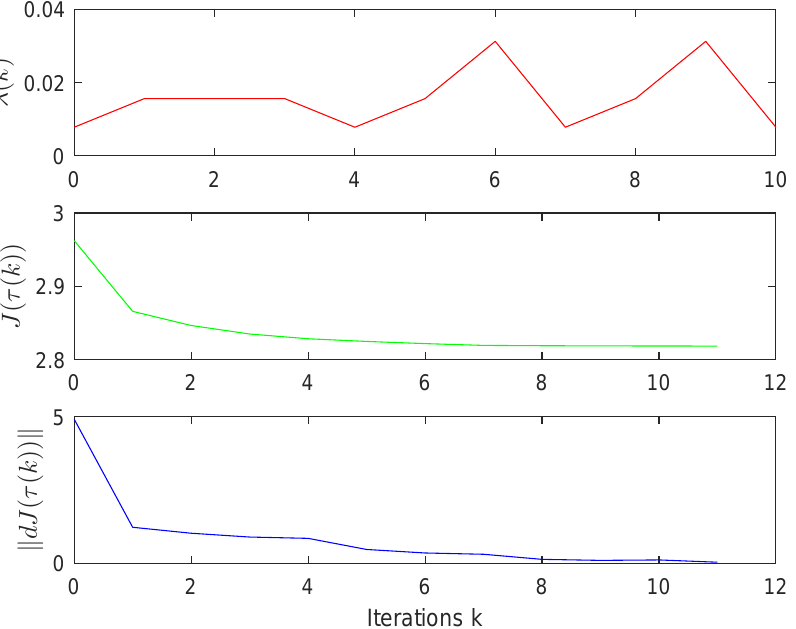
Figure 3. The designed step size λ ( k ) , the cost functional J ( τ ( k )) and gradient (cid:107) dJ ( τ ( k )) (cid:107) with k iterations. The optimal switching time is T = [ 0.2609, 0.4677, 0.7749 ] after ten iterations.